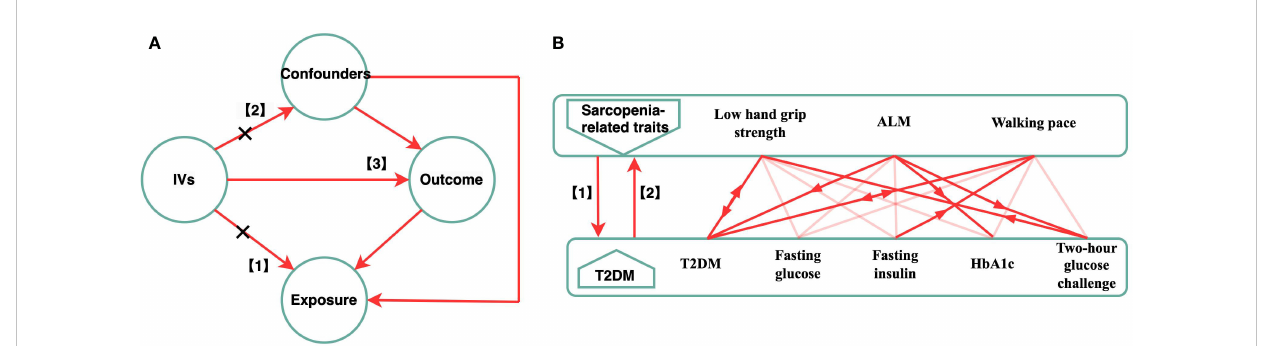
FIGURE 1 Schematic diagram of the Bi-directional MR Analysis. (A) illustrates three assumptions of MR analysis as follows: 1) the IVs have a signi fi cant correlation with the exposure; 2) the IVs also had no pleiotropic correlations with any known confounding factors; and 3) the IVs have no connection with the outcome, with the possible exception of how that link is mediated by their association with the exposure. (B) This bidirectional MR analysis was performed in two steps: sarcopenia-related traits (hand grip strength, ALM, walking speed) was studied as exposure while T2DM and glycemic characteristics were studied as outcome in the fi rst step, whereas the second step was reversed. The arrows indicate direction of causality in our results. MR, mendelian randomization; IVs, instrumental variables; T2DM, Type 2 diabetes mellitus; ALM, appendicular lean mass.